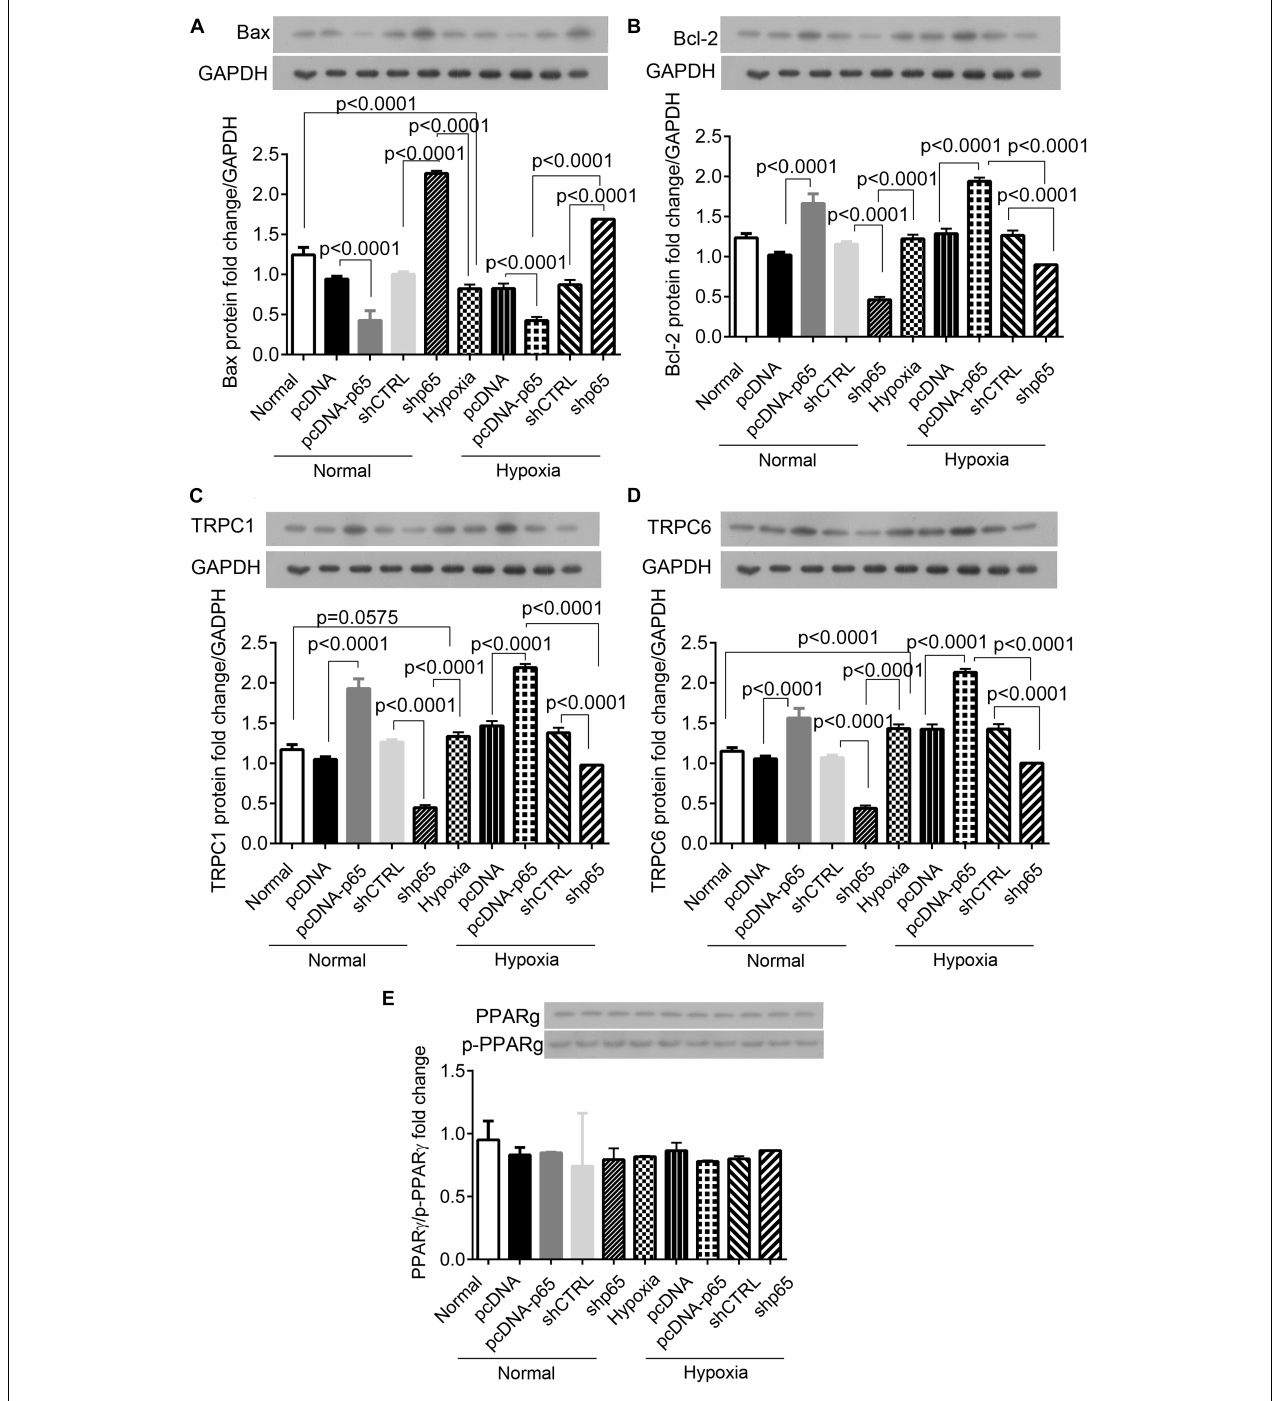
FIGURE 6 | The expression of Bax, Bcl-2, TRPC1, TRPC6, and PPAR γ proteins in the hPASMCs. (A,B) The expression of Bax and Bcl-2 proteins in the hPASMCs in response to hypoxia, pcDNA-p65, and shp65 treatments. (C,D) The expression of the TRPC1 and TRPC6 proteins. (E) The fold change of the p-PPAR γ to total PPAR γ . Each experiment was repeated three times. The differences were analyzed using one-way ANOVA. CTRL,